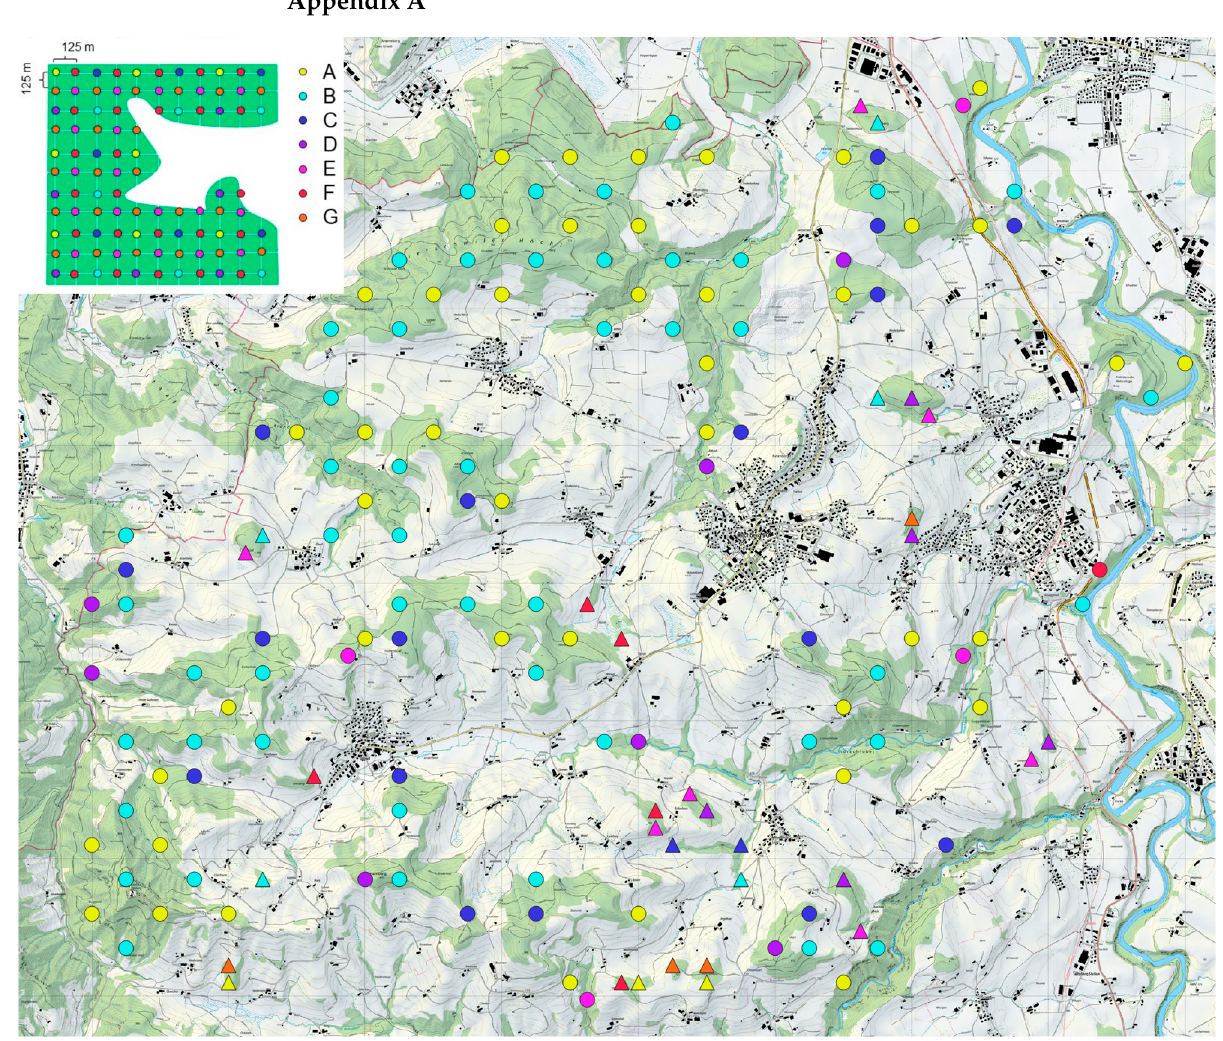
Figure A1. Seven systematic grids of sample plots were placed (A-grid to G-grid). A-grid: basic 500 m × 500 m; B-grid 500 m × 500 m but shifted diagonally from A-grid so that A and B together resulted in a 353 m × 353 m grid. C-grid and D-grid: 500 m × 500 m but shifted horizontally (C-grid) or vertically (D-grid) from A-grid, resulting in a 250 m × 250 m grid for A to D considered together. E-grid, F-grid and G-grid: 250 m × 250 m grid shifted diagonally (E-grid), horizontally (F-grid) or vertically (G-grid) from the combined A–D grid. Circles represent “larger” forest complexes, i.e., >10 ha cohesive forest, while triangles represent forest islands. Small forest areas that were attached to a larger forest complex via a narrow corridor were considered part of the forest complex. Large forest complexes (>20 ha) were represented by at least five plots and at least one in each connected part. In smaller forests (10 ha > x < 20 ha), a minimum of three plots were sampled, while in island forests a maximum of three plots were sampled.